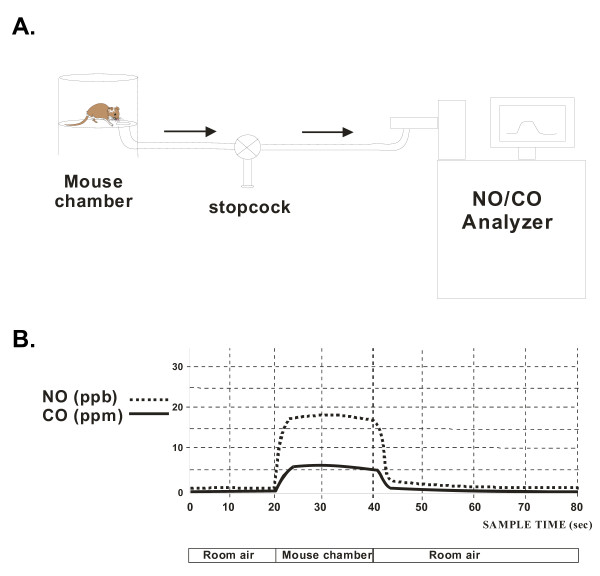
Schematics of exhaled gas setup and data. A. Schematic of experimental setup used to measure exhaled NO and CO in mice. Expired gas from the mouse was sampled from small holding chamber, with an integral stopcock to allow rapid sample switching from ambient to expired air. B. Schematic representation of signals redrawn from actual signals of one individual mouse with airway inflammation. Increased NO (16–18 ppb) and CO (5–7 ppm) is apparent in first 10s of 20s sampling period, when sampling chamber air, as compared with low concentrations of NO (0–2 ppb) and CO (0–1 ppm) in ambient air, pre- and post-sampling of chamber. Additional details are in text.